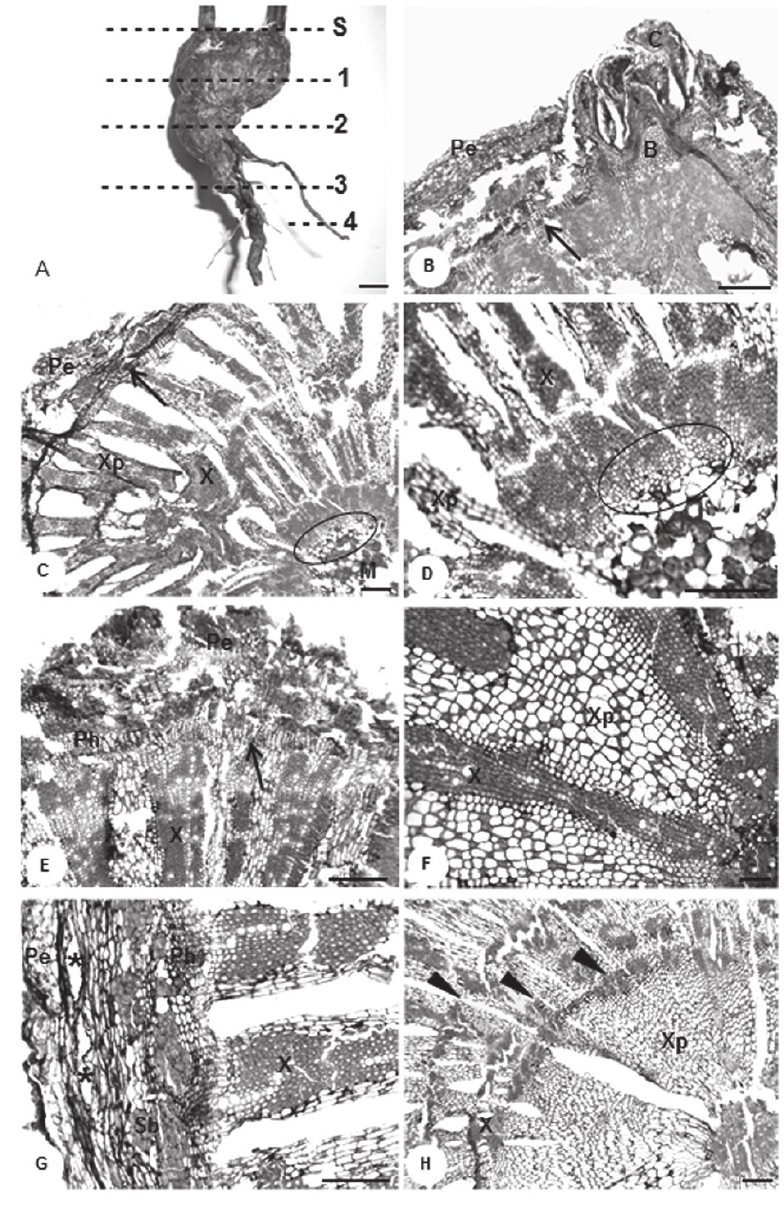
Fig. 3 - Underground organs of Dimerostemma vestitum indicating the analyzed portions (A): Soil level (S); Proximal region (1); Median region (2); Distal region (3); Lateral root (4). Longitudinal sections of the buds of the xylopodium of D. vestitum stained with toluidine blue (B). Arrow heads indicate the vascular cambium; cataphyll (C); bud (B); periderm (Pe). (C-H) Transversal sections of the xylopodium. (C-D) Proximal region, detailing the centrifugal maturation (circle) of primary xylem (D). (E-F) Median region of xylopodium showing the formation of periderm, secondary xylem rays and vascular cambium (arrow). (G-H) Distal region of the xylopodium showing (G) periderm (Pe), secretory canals (*) and fibers associated to phloem (Sb). (H) Growth layers (arrow heads) of secondary xylem (X), xylem parenchyma (Xp) and phloem (Ph). Scale bars: 1cm (A); 1000 µm (B, E); 3000 µm (C, H); 500 µm (D, F,